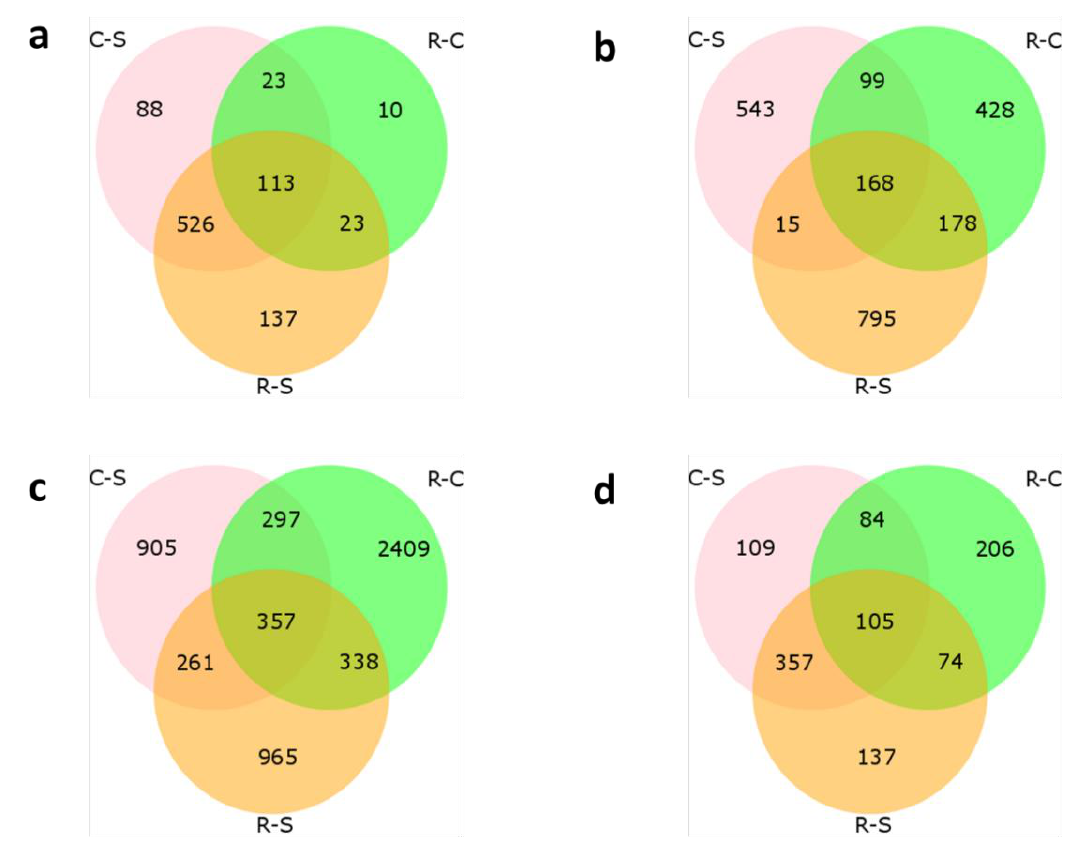
Figure 1. Venn diagrams showing the number of differentially expressed genes in each population compared to the FANG susceptible colony: ( a ) Cameroon population, ( b ) Ghana population, ( c ) Uganda population and ( d ) Malawi population. R-C: genes induced upon exposure and constitutive expression (resistant vs control unexposed), C-S: constitutive differential expression (control vs susceptible); R-S: genes induced upon exposure and constitutive expression (resistant vs